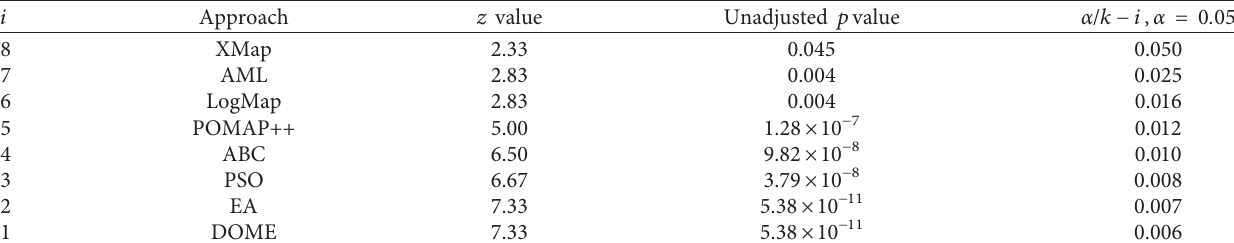
Table 3: Holm’s test on the alignment’s quality.